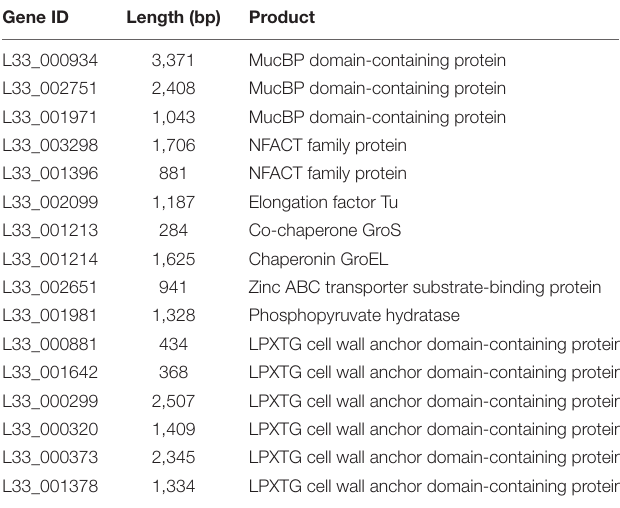
TABLE 3 | List of proteins involved in the adhesion of L. pentosus L33 on host cells.